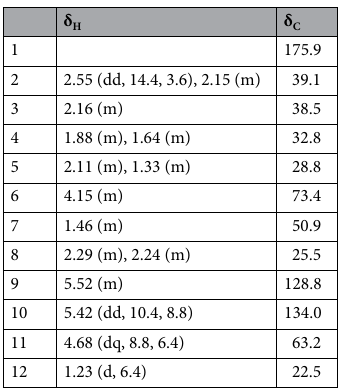
Table 1. NMR spectroscopic data for compound 5 (CD 3 OD).